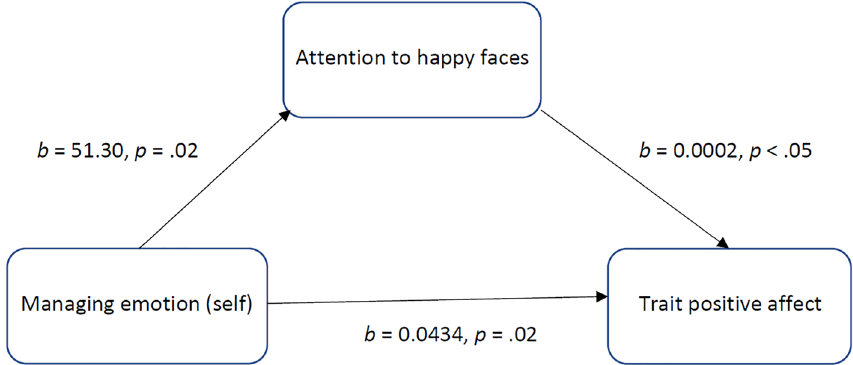
Figure 1. The mediating effect of attention to happy faces (dwell time on happy faces) in the relationship between managing emotion (self) and trait positive affect (PANAS). All presented effects are unstandardized.